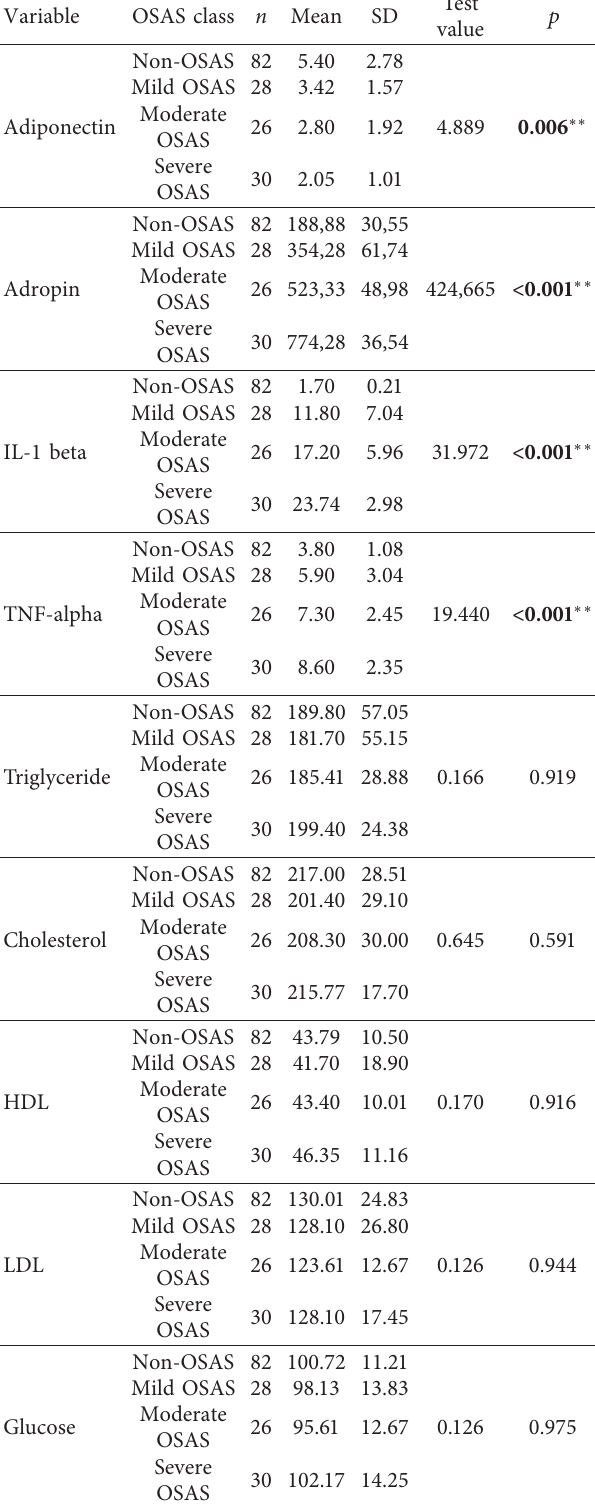
OSAS: obstructive sleep apnea syndrome; Ort: average; SS: standard de- viation; TNF-alpha: tumor necrosis factor-alpha; HDL: high-density li- poprotein; LDL: low-density lipoprotein. ∗∗ Statistical